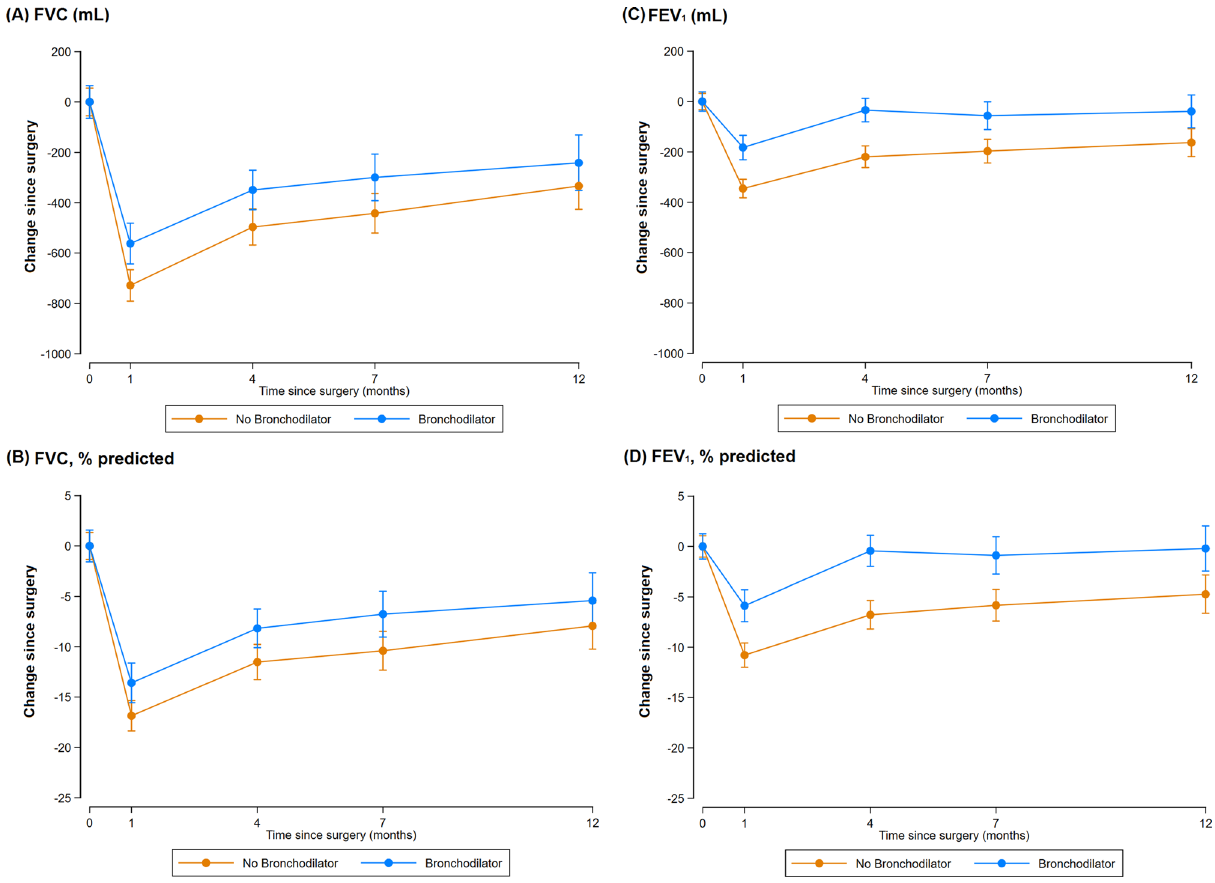
Figure 1. Changes in pulmonary function from baseline to 1, 4, 7, and 12 months following lung resection according to perioperative bronchodilator use.